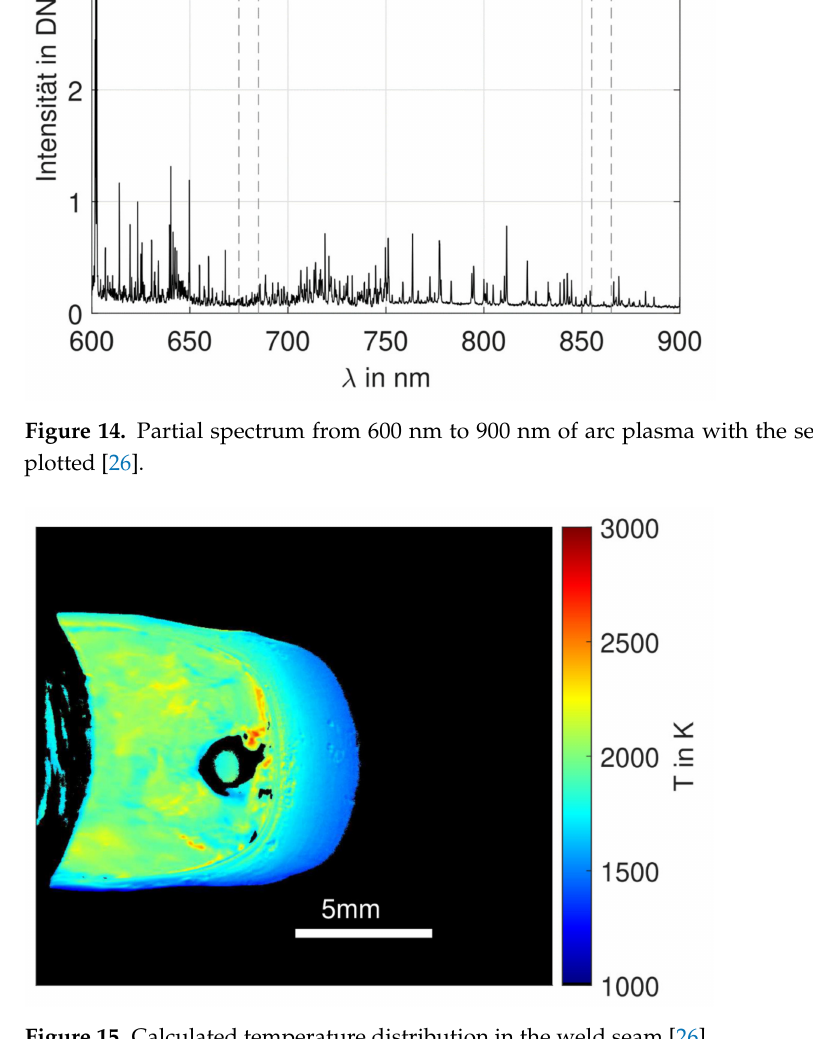
Figure 15. Calculated temperature distribution in the weld seam